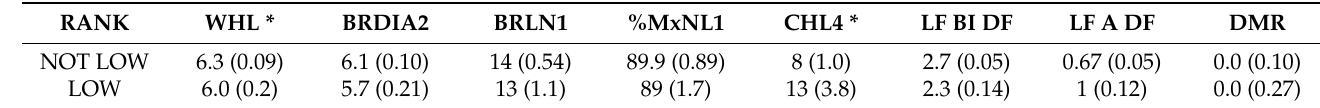
Table 5. Tree-vigor attribute values (MEANS and SE) for trees in the two vigor classes. Marked (*) attributes significantly differed ( p < 0.05) using the Wilcoxon rank sum test. Tree-vigor attribute attributes were defined as follows: WHL is the number of years needles retained; BRDIA2 is the previous year branchlet diameter ( ± / − 0.01mm); BRLN1 is the current year branchlet length ( ± / − 2.0 mm); %MxNL1 is the current-year needle length relative to the longest needles produced on the branchlet; CHL4 is the level of chlorosis in 4-year-old needles; LF BI DF is a synthetic index of foliar (biotic) insect defoliators (including summed frequency of weevil, unknown phloem feeders, and scale); LF A DF is the summed frequency of needle tip dieback, dead needles, and early senescence; DMR is the dwarf mistletoe rating